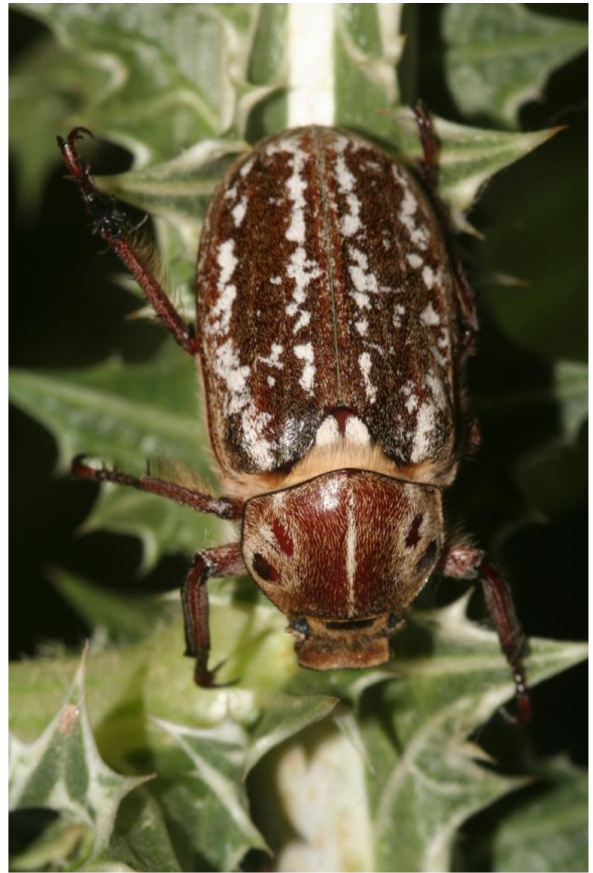
Figure 1. Anoxia orientalis from “Foce del Simeto”,